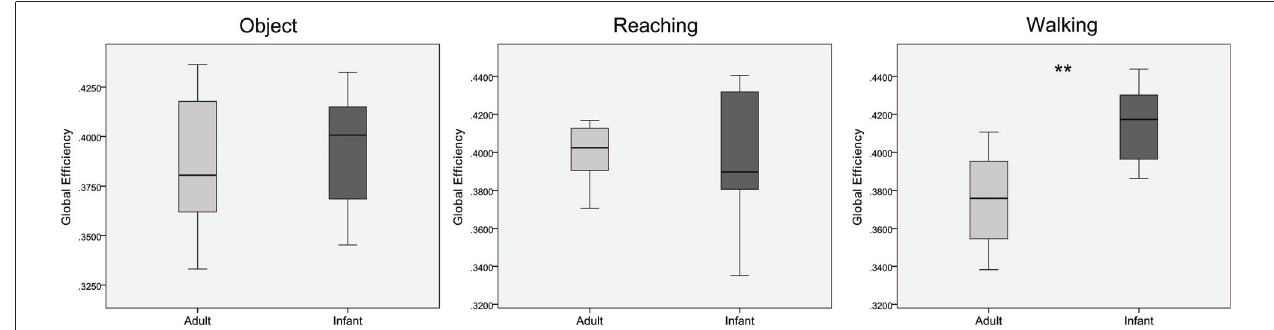
FIGURE 4 | Boxplots showing differences between infants and adults in mean values of global efficiency for the three conditions (from left to right: object, reaching, walking) . ** p < 0.01. Whiskers are representing minimum and maximum points of the